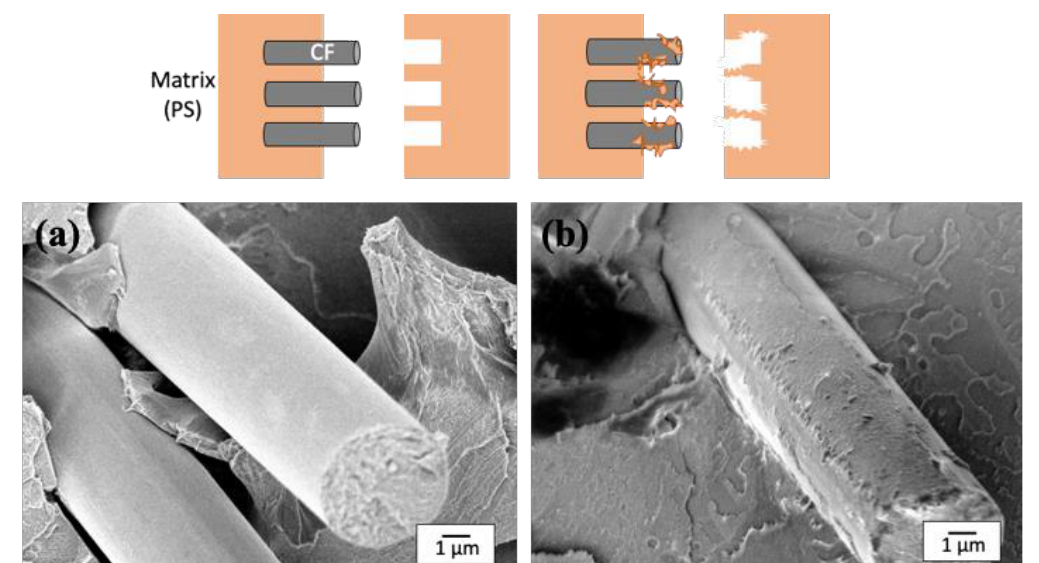
Figure 9. SEM images of freeze-fractured surfaces of the composites after impact tests; ( a ) PS-CF composite (interfacial peeling) and ( b ) PS-CF/Pipozo/MWCNT composite (cohesive failure).